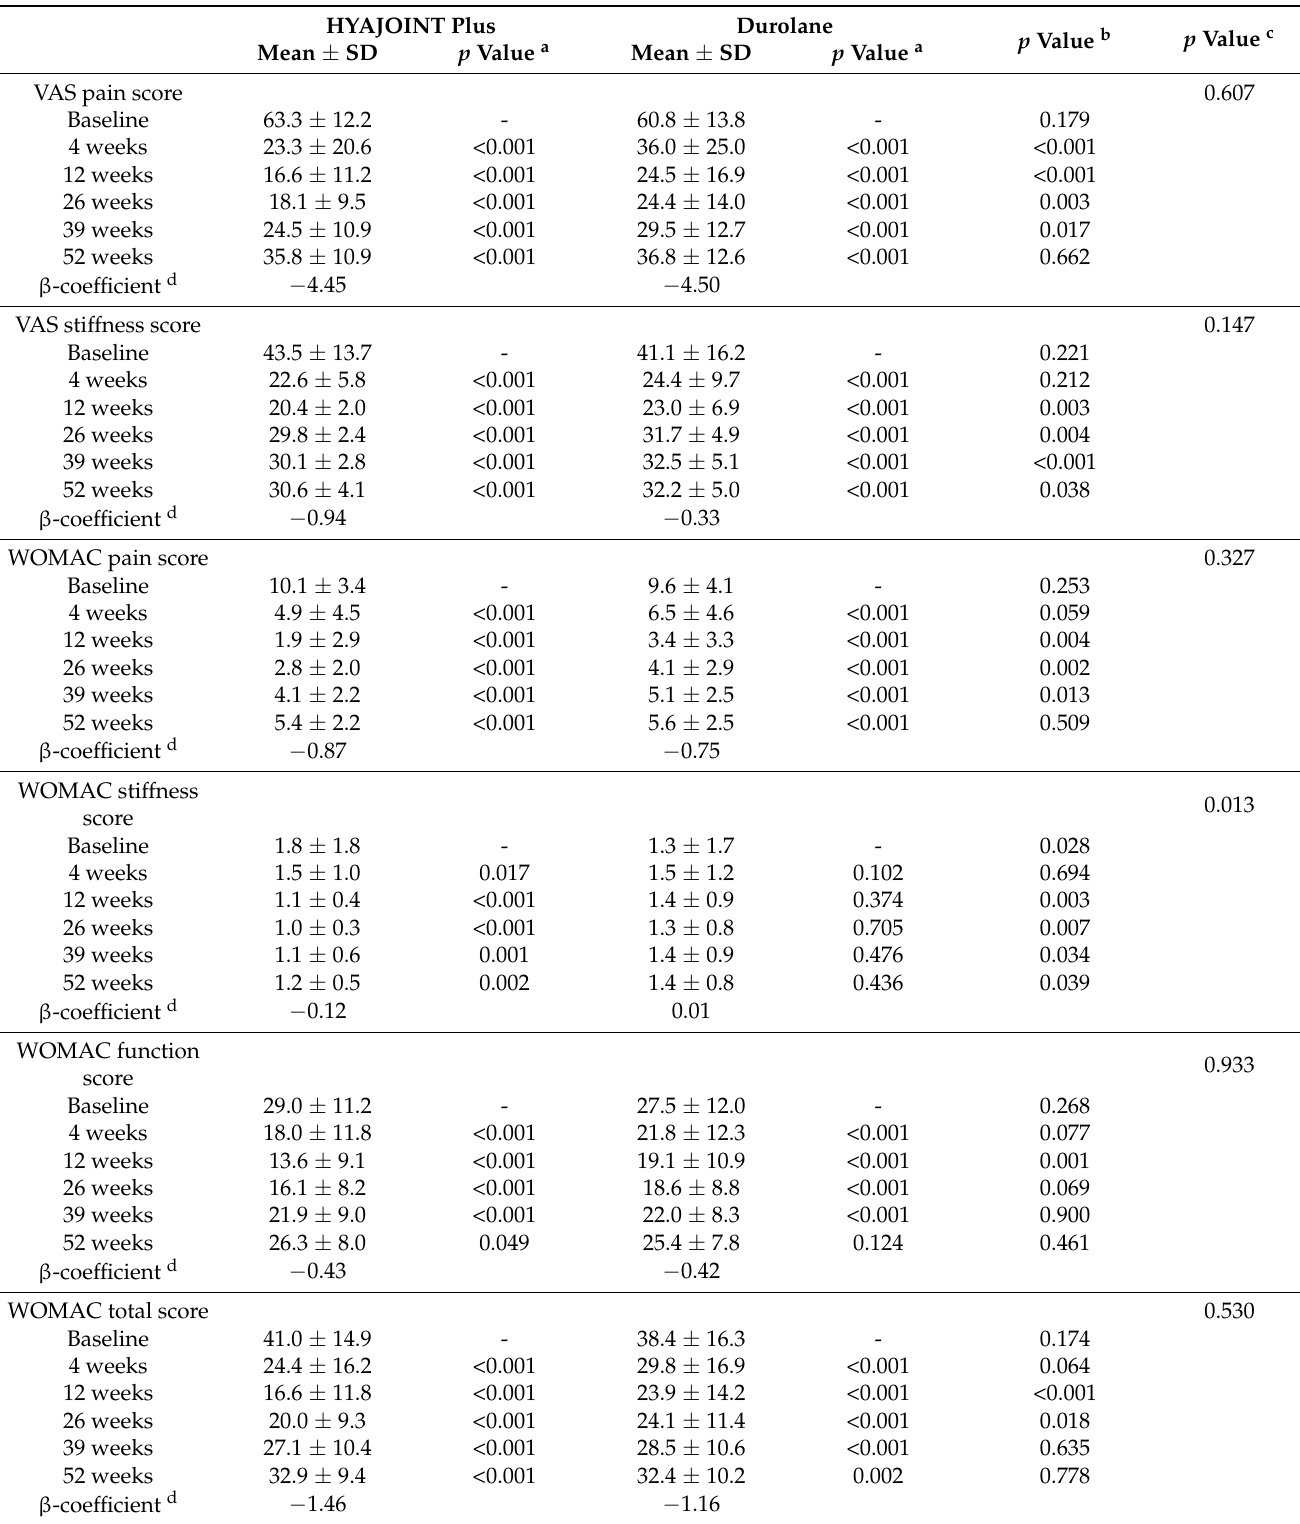
Table 3. Comparison of VAS pain score, VAS stiffness score, WOMAC score, TUG test, and SLS test between groups. HYAJOINT